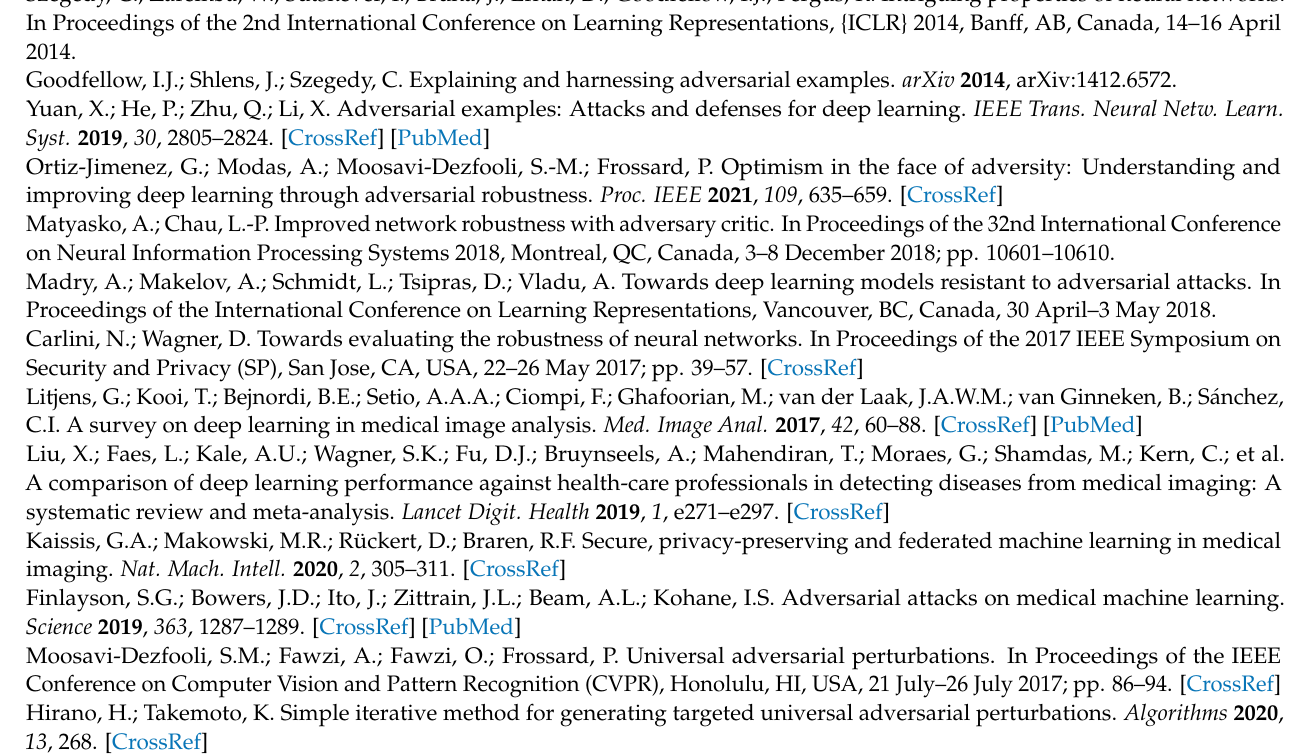
Table S1; List of the abbreviations of the image labels and label composition in each medical image dataset. Table S2: Fooling rates R f (%) of nontargeted UAPs with p = 2 against Inception V3 model for skin lesion images dataset under different random seed